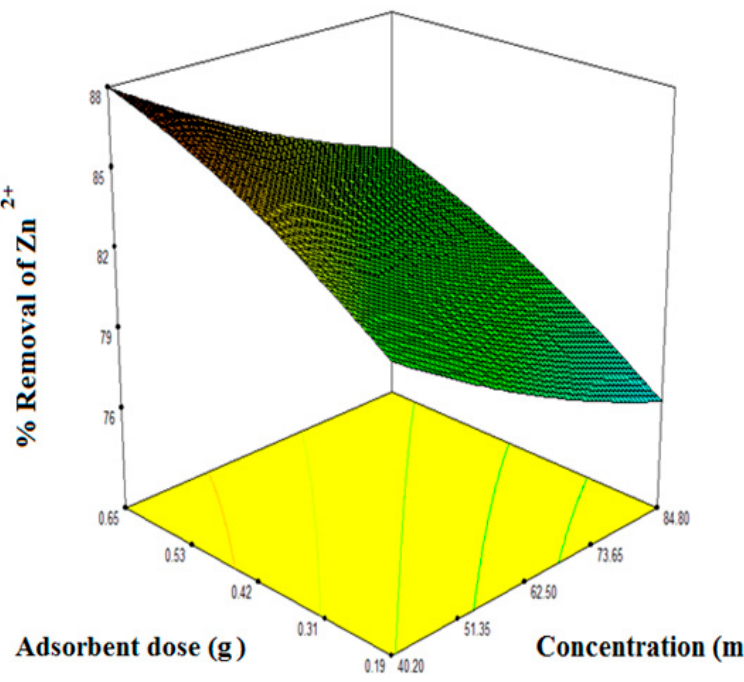
Figure 8. 3D plot at an optimized region on the adsorbent dose and concentration for the highest removal efficiency of Zn 2+ .